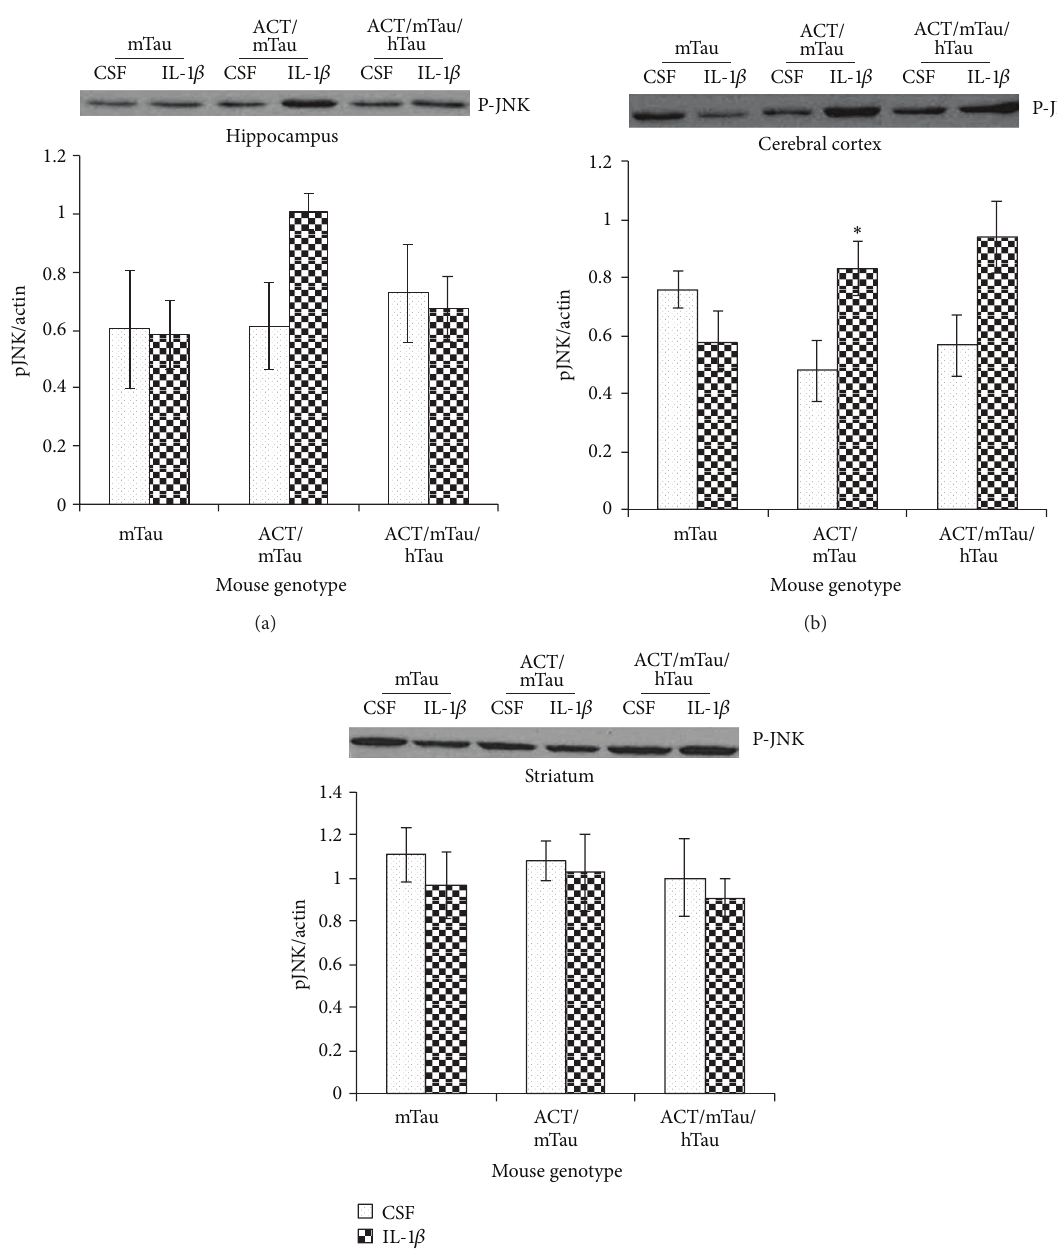
Figure 3: Inflammatory proteins induce tau phosphorylation through JNK activation: JNK phosphorylation in different brain regions— hippocampus (a), cerebral cortex (b), and striatum (c), in mTau, ACT/mTau and ACT/mTau/hTau mice injected with aCSF and IL-1 𝛽 (1ng/10 𝜇 L) ∗ 𝑃 < 0.05 (aCSF versus IL-1 𝛽 treated group). Values are normalized to actin levels. The blot above each bar graph shows a representative western blot showing corresponding P-tau in the samples from different mice. The data was collected from four independent mice from each genotype